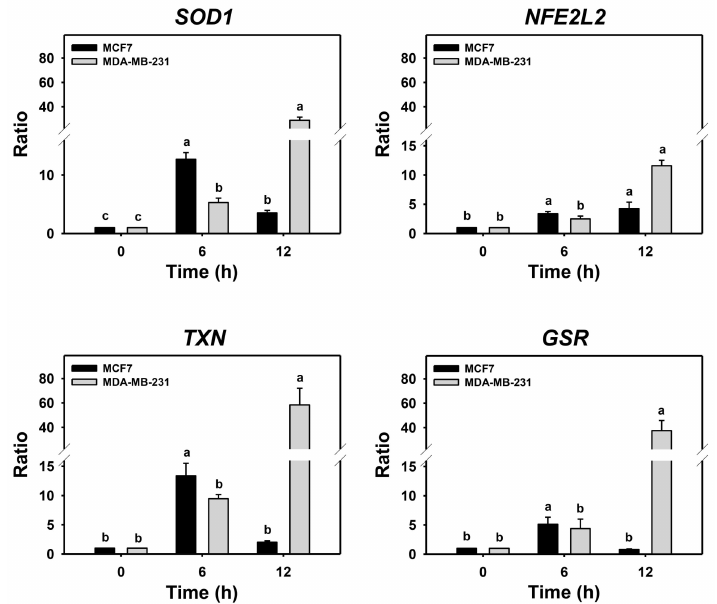
Figure 5. Autophagy downregulation promotes PHA-stimulate antioxidant mRNA expressions in breast cancer cells. The ratio of mRNA expressions for Baf A1/PHA cotreatment/PHA treatment was calculated to determine the impact of Baf A1 on mRNA expressions of antioxidant genes ( SOD1 , NFE2L2 , TXN , and GSR ). When the Baf A1/PHA cotreatment/PHA treatment ratio is larger than 1, it indicates that Baf A1 can stimulate mRNA expressions of test antioxidant genes. Breast cancer (MCF7 and MDA-MB-231) cells were co-treated with PHA (0 (control) and 5 µ M) and Baf A1 (100 nM) for 0, 6, and 12 h. Data, means ± SDs ( n = 3). Data with non-overlapping lower-case letters differ significantly ( p < 0.05 to